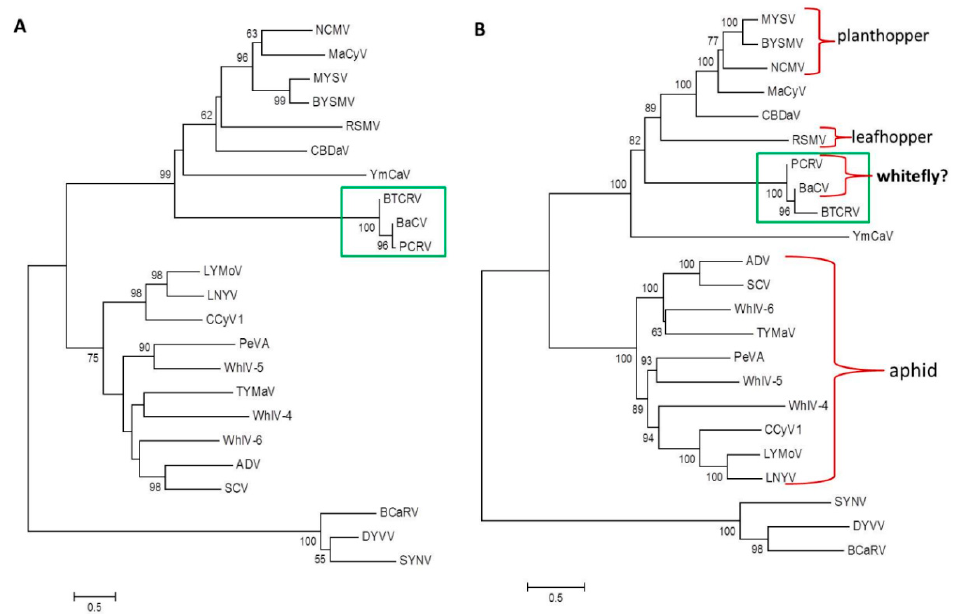
Figure 1. Neighbor joining trees inferred using an alignment of nucleocapsid (N protein) ( A ) and RdRp (L protein) ( B ) from 20 available cytorhabdovirus genome sequences. The genomes of the nucleorhabdoviruses sonchus yellow net virus (SYNV; L32603), datura yellow vein virus (DYVV; KM823531) and black currant-associated rhabdovirus (BCaRV; MF543022) were used as outgroup. The trees were constructed using the JTT model with 1000 bootstrap replicates. BaCV, PCRV, and BTCRV are within a green box. ( B ) also indicates known insect vector types. The cytorhabdoviruses used to construct the tree, and their accession numbers, are: alfalfa dwarf virus (ADV; KP205452), barley yellow striate mosaic virus (BYSMV; KM213865), bean-associated cytorhabdovirus (BaCV; MK202584) Bemisia tabaci virus-like sequences (BTCRV; KJ994260; KJ994261; KJ994263; KJ994264), cabbage cytorhabdovirus-1 (CCyV-1; KY810772), colocasia bobone-disease associated virus (CBDaV; KT381973), lettuce necrotic yellow virus (LNYV; AJ867584), lettuce yellow mottle virus (LYMoV;